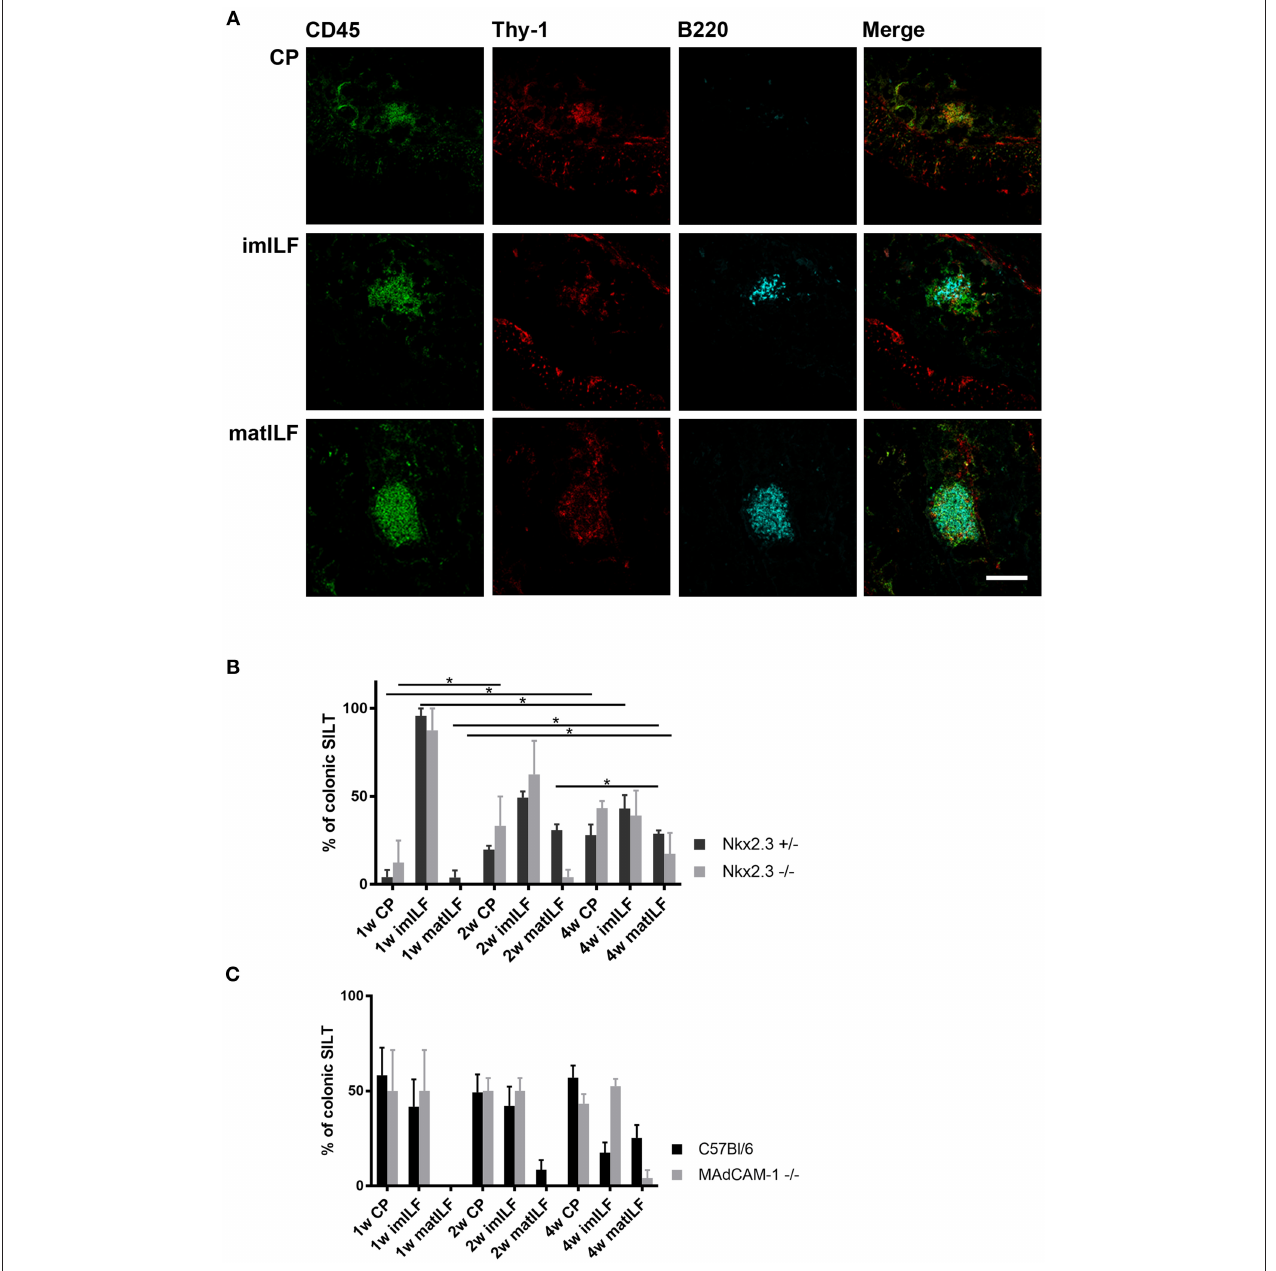
FIGURE 2 | Composition of postnatal colonic SILT spectrum. (A) Representative samples for cryptopatches (CP), immature (imILF), and mature (matILF) isolated lymphoid follicles of a 4 weeks old Nkx2-3 + / − mouse using CD45/Thy-1/B220 combined immunofluorescence staining with the markers as indicated (scale bar = 100 µ m). (B) Composition of colonic SILT spectrum in Nkx2-3 + / − (black filled) and Nkx2-3 − / − (gray filled) mice at 1, 2, and 4 weeks of age as indicated; n = 4; mean ± SEM, * p < 0.05). (C) Composition of SILT spectrum in the colon of wild-type C57BL/6 (black filled) and MAdCAM-1 − / − (gray filled) mice at 1, 2, and 4 weeks of age as indicated ( n = 4; mean ± SEM * p <